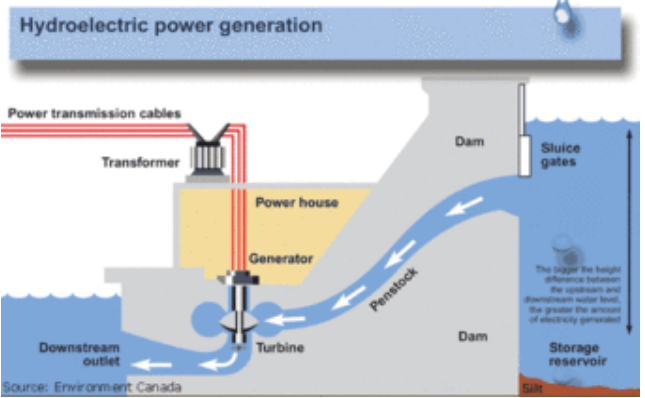
Figure 11. Falling water produces hydro-electric power. Credit: Tennessee Valley Authority.